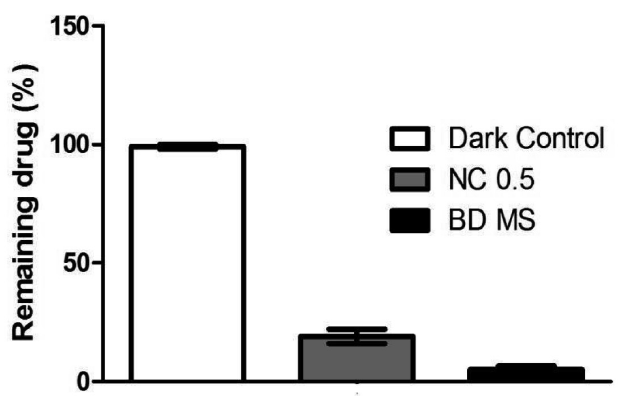
FIGURE 2 - Nanocapsules beclomethasone dipropionate content (NC-0.5), methanolic solution (BD-MS) and dark control under UVC